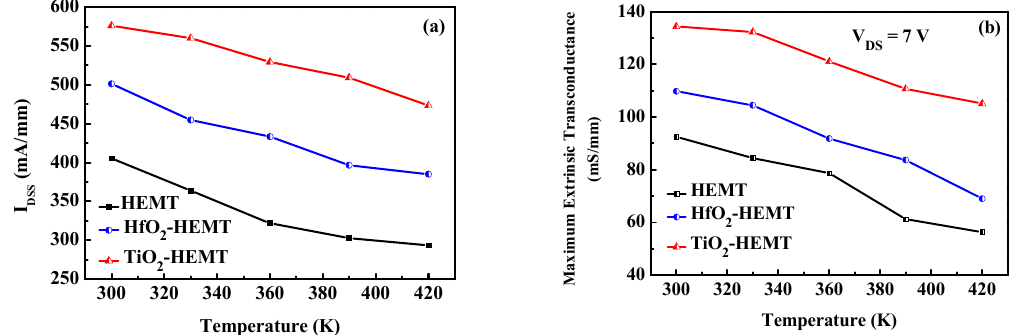
Figure 5. ( a ) I DSS and ( b ) g m,max of the studied HEMTs at various temperatures. Figure 5b plots the maximum extrinsic transconductance ( g m,max ) versus temperature of the investigated HEMTs. When the temperature is increased, the maximum extrinsic transconductance varies in the same tendency as I DSS . At 420 K, the g m,max values for HEMT, HfO 2 -HEMT, and TiO 2 -HEMT are 56.3, 69, and 105 mS/mm, respectively. Experimental results demonstrate the TiO 2 -HEMT perform well even at high temperatures. Two-tone intermodulation distortion is measured to demonstrate the large-signal linearity performance. Figure 6 shows the fundamental and third-order output powers versus input power of the studied devices. The red dashed lines are extrapolated to predict the intersection at the third-order intercept point (OIP3). The values of OIP3 are 10.5, 13.7, and 17.9 dBm, respectively. HfO 2 passivation increases the OIP3 value by around 30% and TiO 2 passivation increases it by 70%. The large-signal linearity of the HEMT is significantly improved when the HEMT is passivated by TiO 2 . The improved device linearity of the TiO 2 -HEMT is attributed to increased g m,max [18] and GVS values